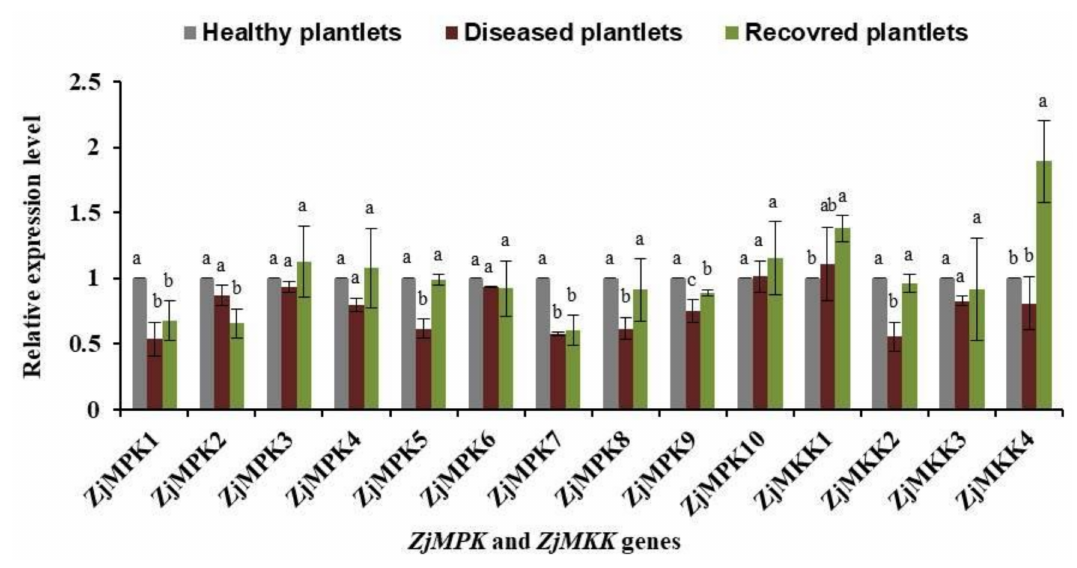
Figure 1. The expression modules of ZjMPK and ZjMKK genes in diseased plantlets and recovered plantlets. ZjACT was used as the internal standard. The healthy plantlets were used as control. The mean expression value was calculated from 3 independent replicates. The vertical bars indicate the standard deviation. Di ff erent letters indicate significant di ff erence at the level of p <